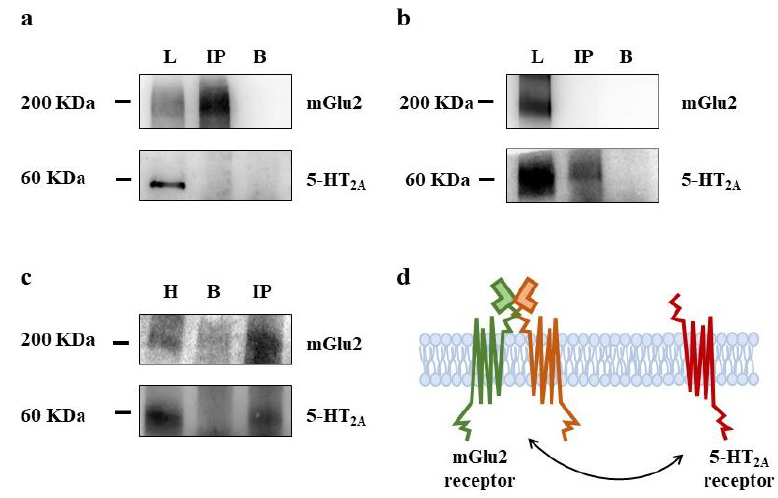
Figure 3. Presynaptic release-regulating mGlu2/3 autoreceptors and 5-HT 2A heteroreceptors do not physically interact in synaptosomes from the prefrontal cortex (PFc) of adult rats. mGlu2 receptor proteins ( a ) and 5-HT 2A receptor proteins ( b ) were immunoprecipitated from lysates of synaptosomes isolated from the PFc of adult rats. Synaptosomal lysates (L), immuno-precipitates (IP) and negative control (B), here used as a negative control, were analyzed for the presence of mGlu2 and of 5-HT 2A immunopositivity. ( c ) mGlu2 receptor proteins were immunoprecipitated (IP) from PFc homogenates and analyzed for the presence of mGlu2 and 5-HT 2A receptor proteins (H); negative control (B). The figures in panels ( a – c ) are representative of the analysis of five different samples for each experimental condition. ( d ) The cartoon illustrates the colocalization but not the physical association of the mGlu2/3 receptors and the 5-HT2A receptors in PFc synaptosomes. The anti-mGlu2 immunoprecipitate was immunopositive for the mGlu2 receptor protein, but not for the 5-HT 2A protein (Figure 3a). Similarly, the anti-5-HT 2A immunopre- cipitate from PFc synaptosomes was immunopositive for the 5-HT 2A receptor proteins but not for the mGlu2 one (Figure 3b).